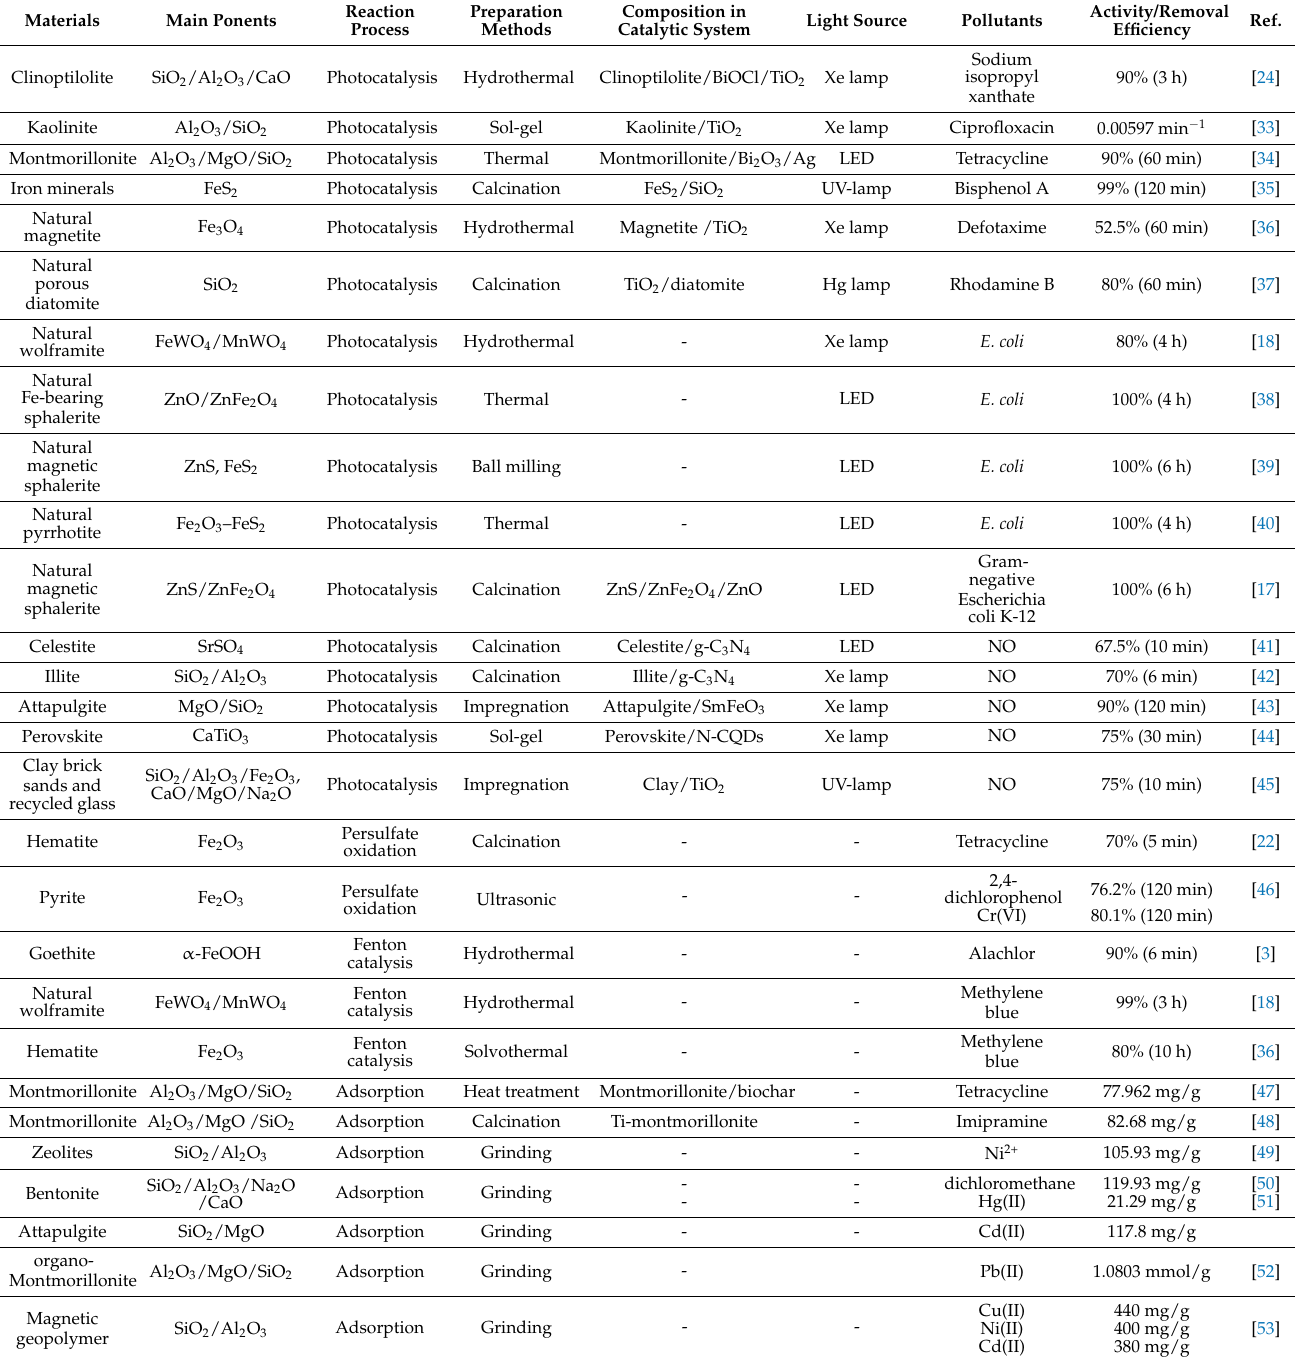
Table 1. Summary of preparation method, reaction process, and practical application of different types of natural minerals in environmental